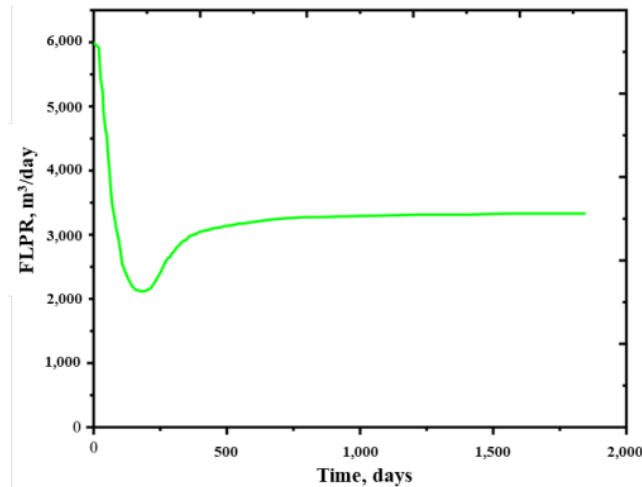
Figure 21. Field oil recovery efficiency for vertical wells.